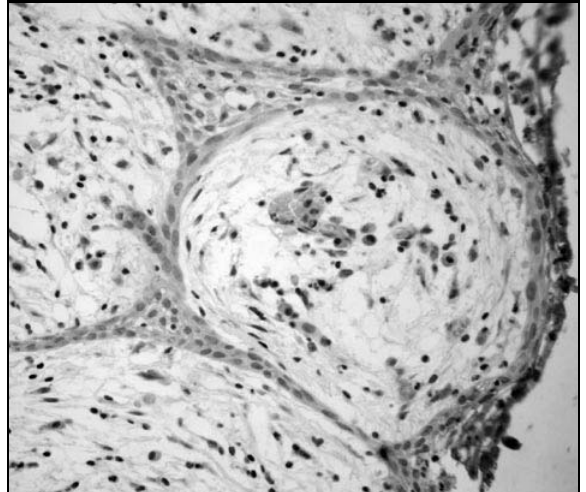
Figura 4 – Imunomarcação para MMP-9 no epitélio e na cápsula de cisto radicular (SABC, 200x)